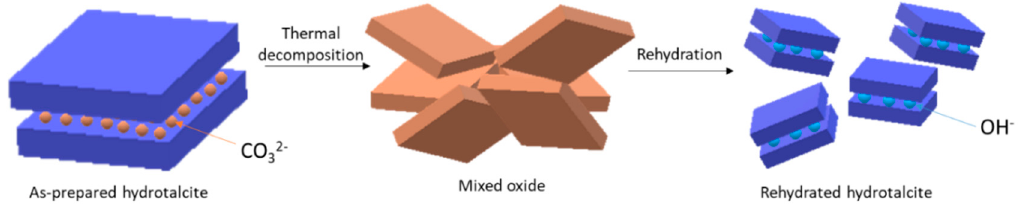
Figure 2. Hydrotalcite activation for catalysis.